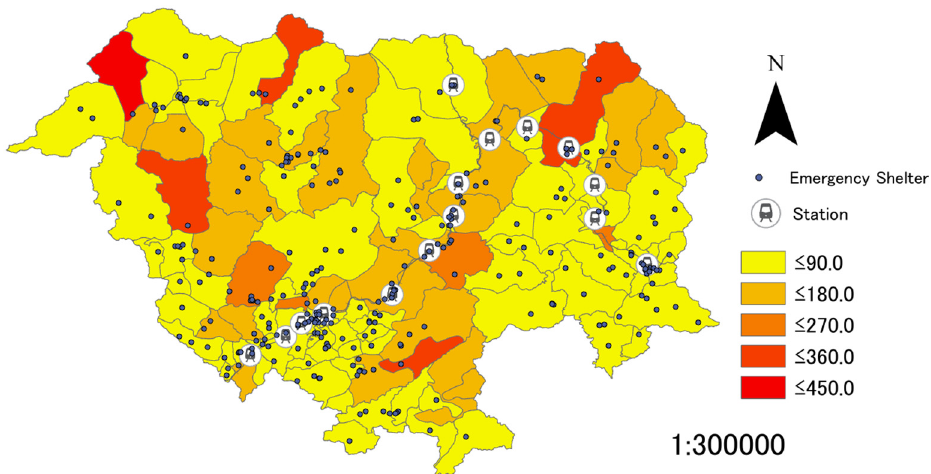
Figure 16. Result for Shobara City without a weighted coefficient.